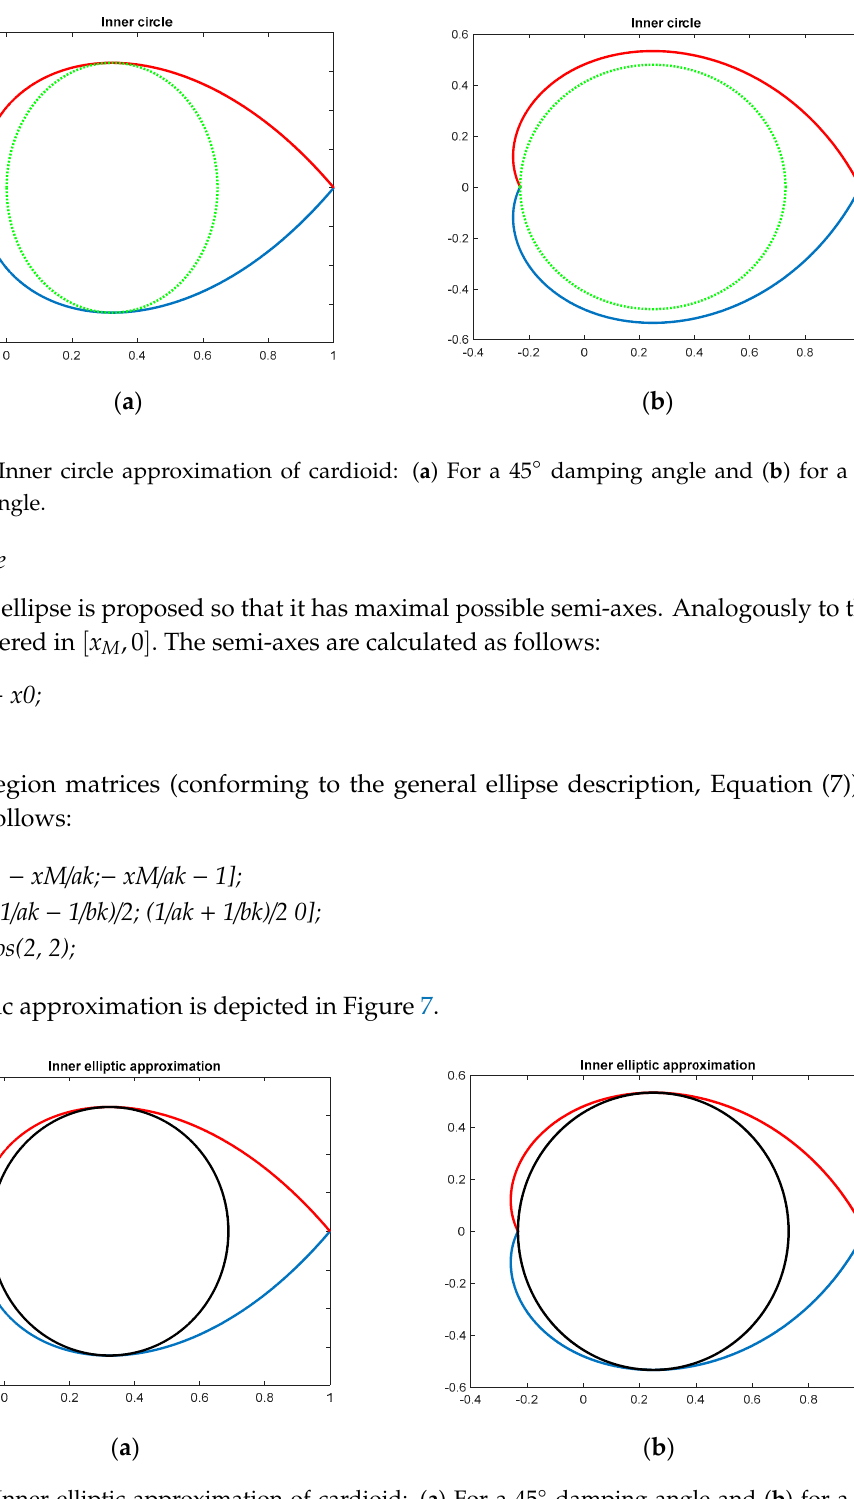
damping angle. damping